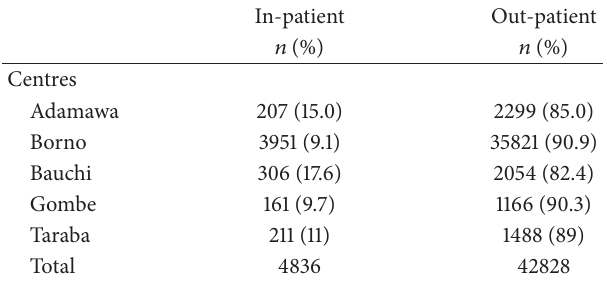
Table 2: Utilization of mental and neurological services in the northeastern Nigeria between 2001 and 2011.